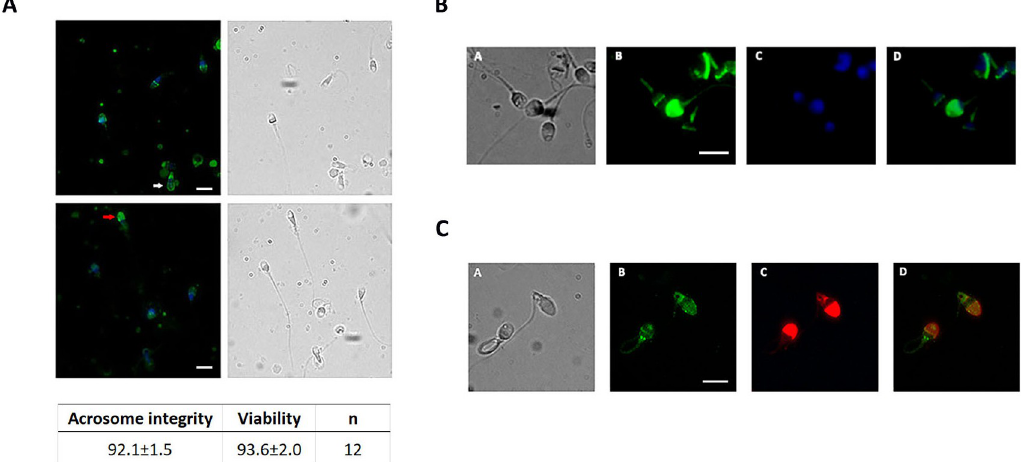
Fig 2. Membrane and acrosome integrity of spermatozoa labeled with anti- α 5 antibody. A) A representative microphotograph of human sperm, at T = 0, labeled with Hoechst 33258 (viability) and PSA-FITC (acrosomal status). Percentages of acrosomal loss and viability are shown. Red arrow indicates a viable sperm with intact acrosome and white arrow indicates a viable sperm with impaired or reacted acrosome. B) Spermatozoa labeled with anti- α 5 and Hoechst 33258; A. phase contrast; B. integrin α 5 label; C. Hoechst 33258; D. merged. M: 1000x (n = 3). C) Spermatozoa labeled with anti- α 5 and PNA-Alexa 594. Spermatozoa were permeabilized after fixation indicating that labeled acrosome is an intact acrosome. A. phase contrast; B. integrin α 5 label; C. PNA-Alexa 594; D. merged. Bar scale: 5 μ m; M: 1000x (n = 3).